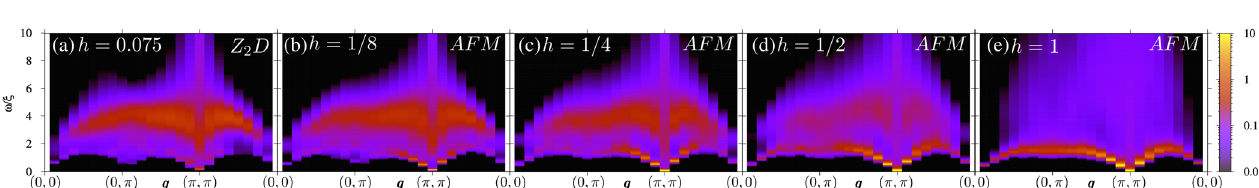
FIG. 12. Dynamical spin structure factor for the N ¼ 2 model as a function of h . For the smallest value of h , we have considered β ¼ 60 as opposed to β ¼ 40 for other values of the transverse field. This choice of temperature places us below T